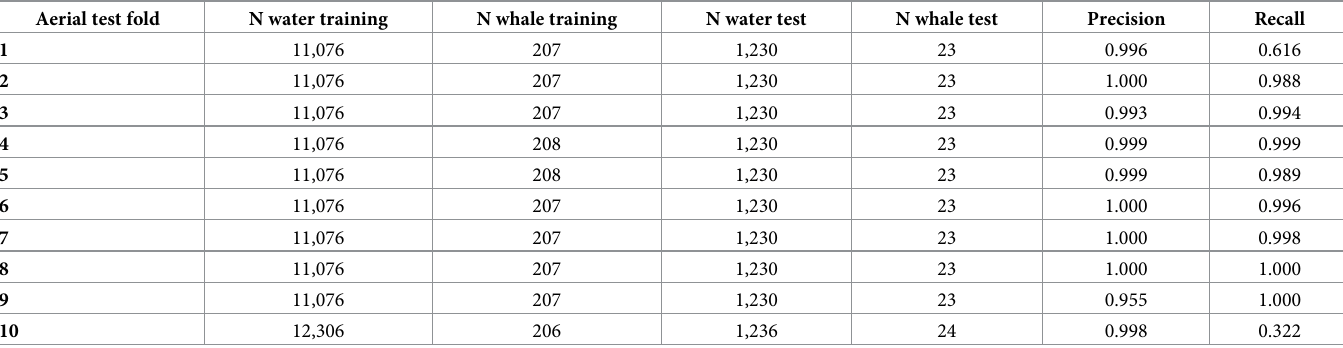
Table 2. Results at the final epoch of 10-fold